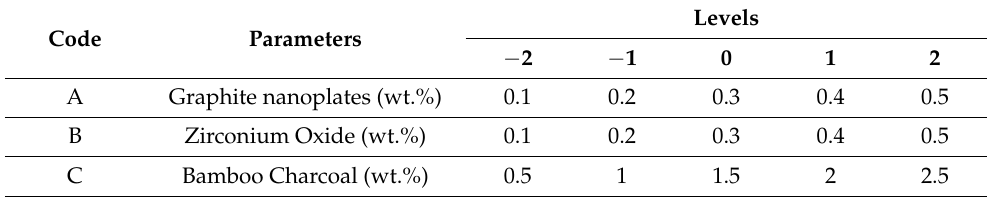
Table 6. Different levels of nanoparticles worn in flexible bio-based polyurethane foam.